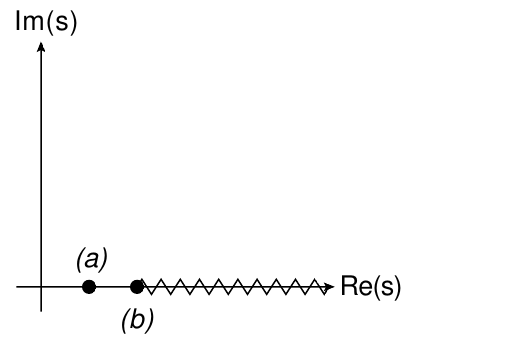
Figure 2: Example singularity structure of the complex scattering amplitude A ( s ) in the complex s plane, showing (a) a pole; (b) a branch